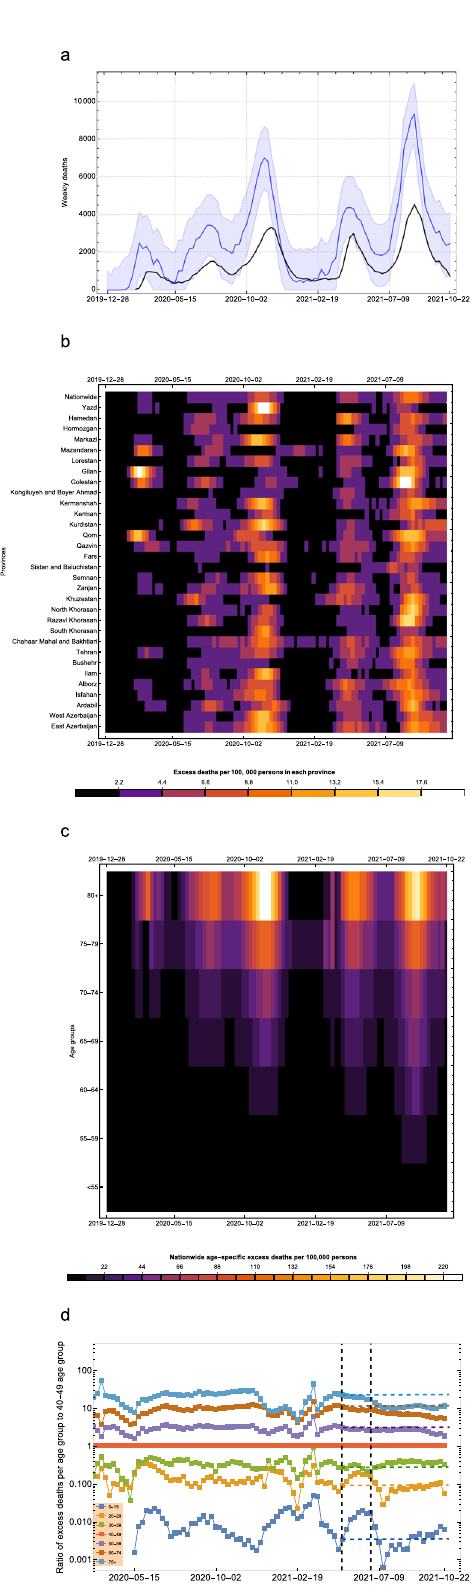
groups for vaccination in Iran are frontline healthcare workers as well as those aged 80 and above; see 20 for more information), and that Iran fully vaccinated roughly 5 times the population size of individuals aged 75 and above by 2021-09-07, it is likely that the